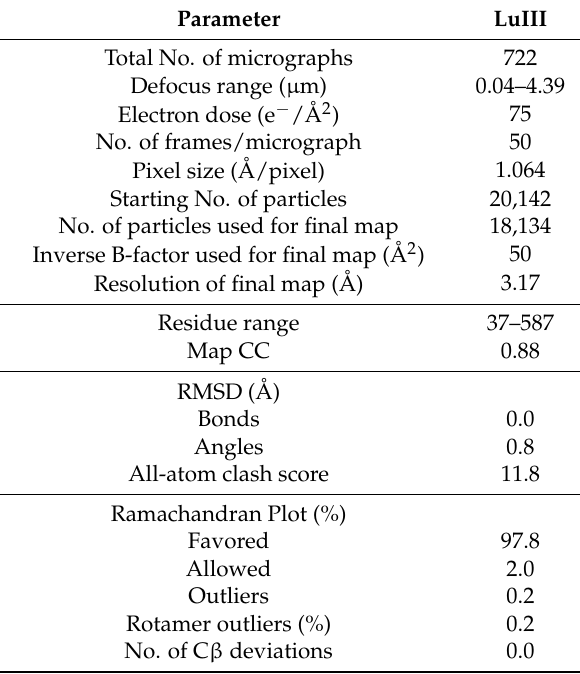
Table 1. Data collection, image pre-processing, and PHENIX